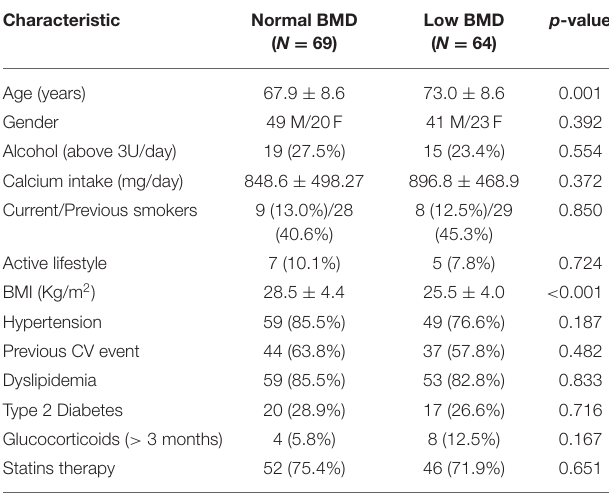
TABLE 1 | Clinical characteristics, co-morbidities and therapies of atherosclerosis patients with normal and low BMD.